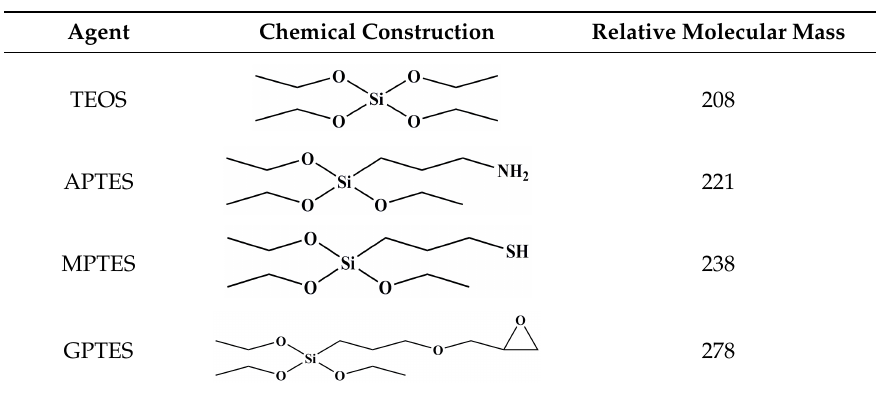
Table 1. Relative molecular mass and chemical structural formula of silane coupling agent.